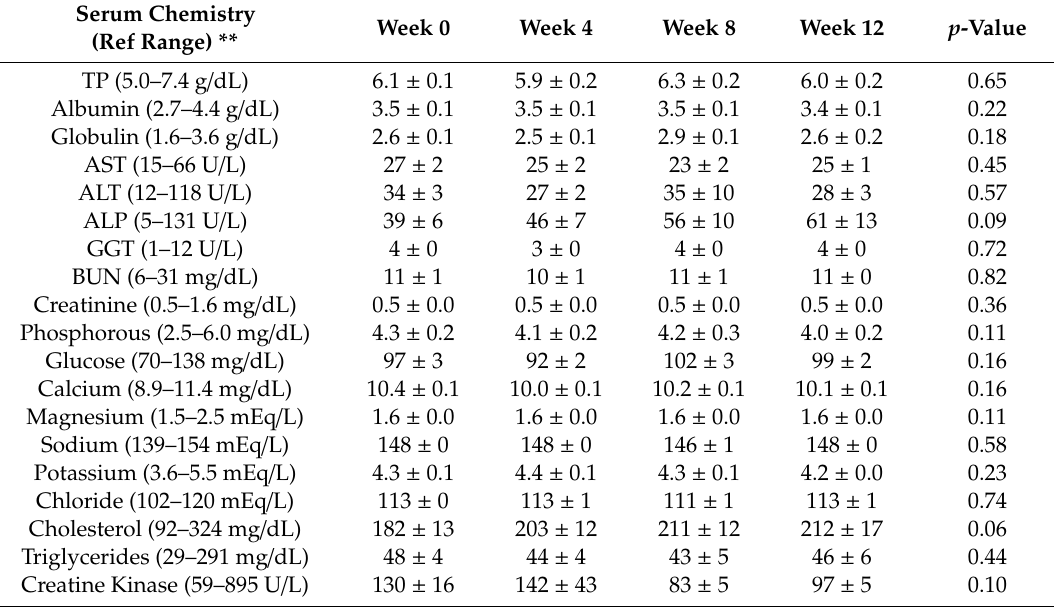
Table 4. Dog ( n = 8) mean and SEM of serum chemistry parameters immediately prior to (week 0), 4 weeks, 8 weeks and 12 weeks of an oral 2 mg / kg CBD dose twice daily using a CBD-rich hemp